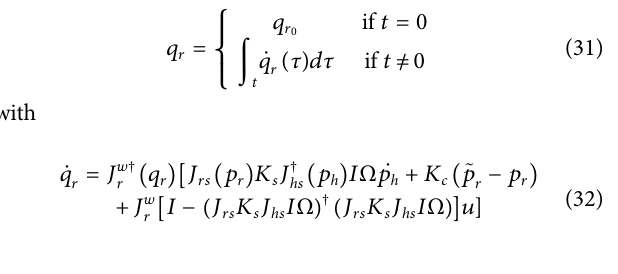
Frontiers in Robotics and AI |